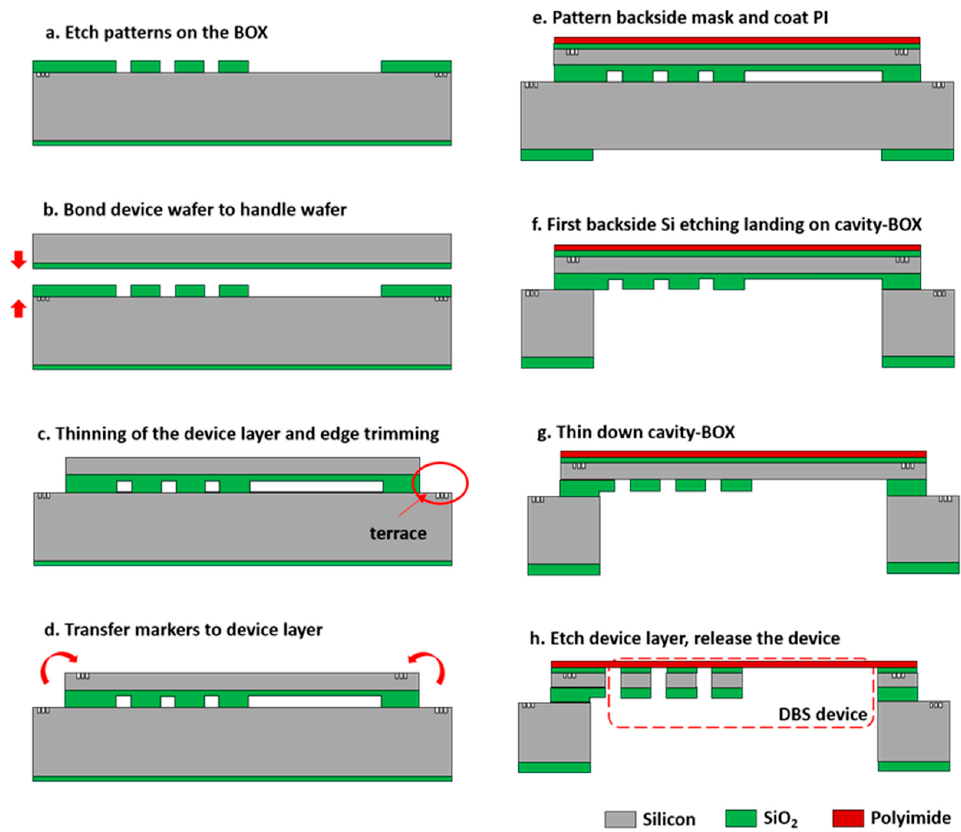
Figure 5. Cross-section drawings of the cavity-BOX substrate preparation and DBS demonstrator fabrication. ( a ) Positioning markers at 1.2 mm to wafer edge and etching patterns in the BOX on top of the 380 µm handle wafer. ( b ) Fusion bonding of the device wafer to the handle wafer with patterned BOX (in vacuum and room temperature. ( c ) Thinning of device layer to 80 µm and edge trimming to create a 4 mm width terrace. ( d ) Transfer markers from the terrace to the device layer. ( e ) Patterning backside etching mask and coating wafer with polyimide, using silicon oxide as an adhesive layer. ( f ) Etching handle wafer from wafer backside and landing on the cavity-BOX. ( g ) Thinning down the cavity-BOX and exposing the buried oxide mask for device layer etching. ( h ) Etching device layer and silicon oxide adhesion layer, landing on polyimide.